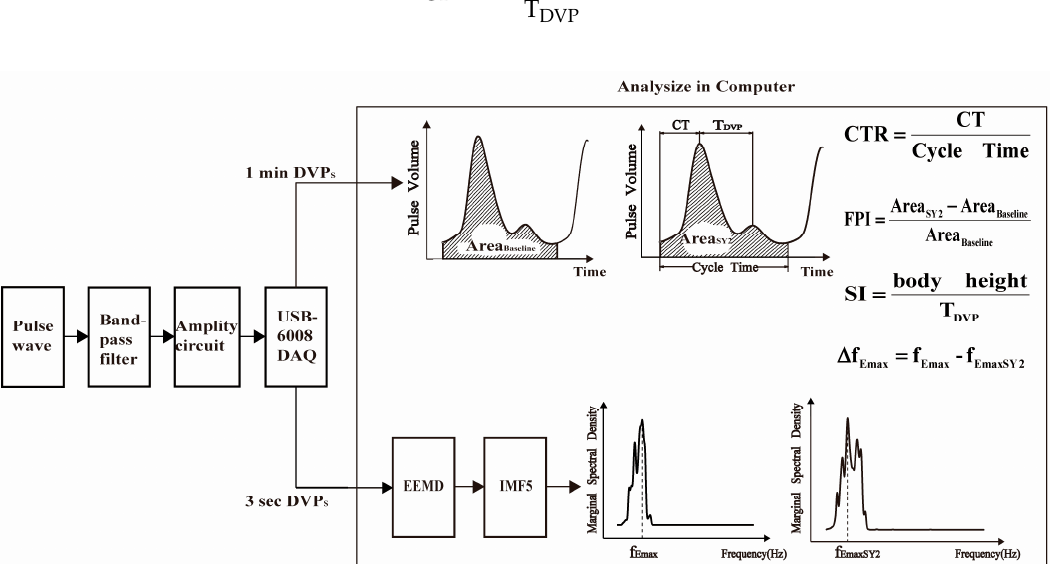
Figure 2. Hardware block diagram of the PED system. After filtration and amplification, waveform signals from the photoplethysmography (PPG) sensor went through a USB-6008 DAQ, which stored the digitized digital volume pulse signals in a computer using the LabVIEW G programming language for data analysis, evaluating the applications of PPG contour analysis in the time domain and the Hilbert–Huang transformation (HHT) domain. CT: crest time (i.e., time from the foot point to the peak of a waveform); CTR: crest time ratio; FPI: finger perfusion index; SI: stiffness index; Δ f Emax : instantaneous frequency difference (i.e., f Emax : the instantaneous frequency of maximal energy, before the use of far-infrared fabric (SY2); f EmaxSY2 : the instantaneous frequency of maximal energy with the SY2 attached).